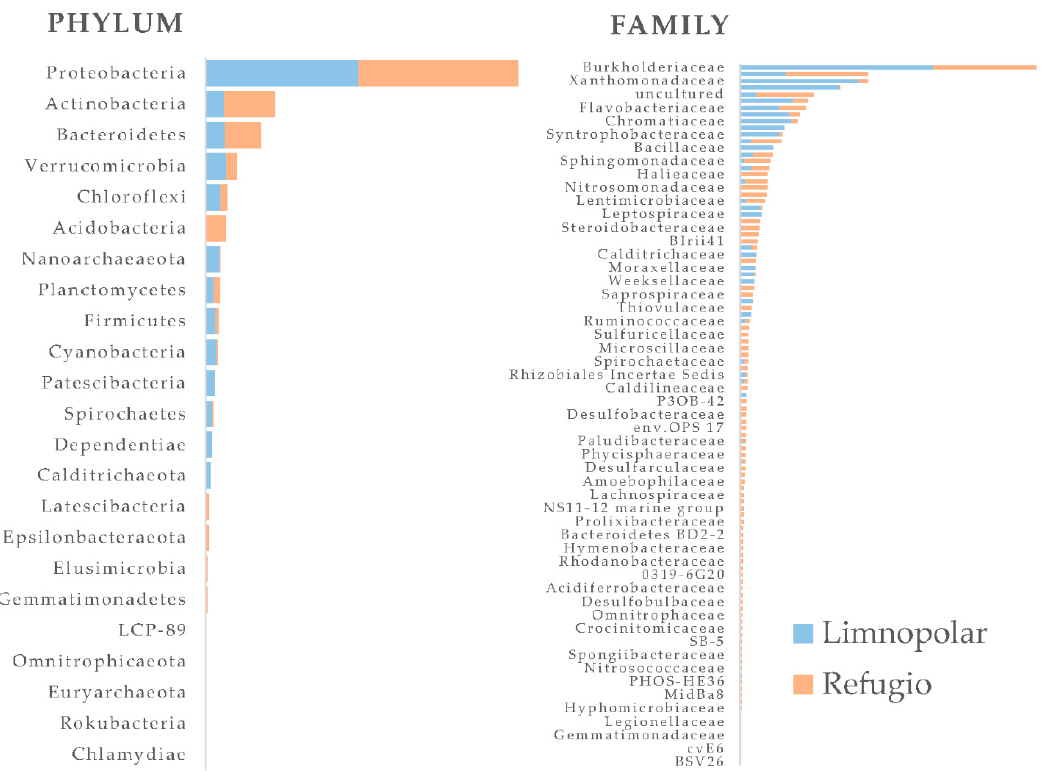
Figure 4. Normalized reads assigned to prokaryotic phyla and families obtained by massive sequencing of the 16S rRNA encoding DNA gene recovered from surface waters of the inland oligotrophic Lake Limnopolar and the coastal eutrophic Lake Refugio. Data redrawn from Picazo et al. [33]. Interactive Krona charts are provided as supplementary material. The complete taxonomic affiliation of families shown in the figure can be accessed in the interactive krona charts provided as Supplementary Material for Lake Limnopolar (Figure S1) and Lake Refugio (Figure S2).